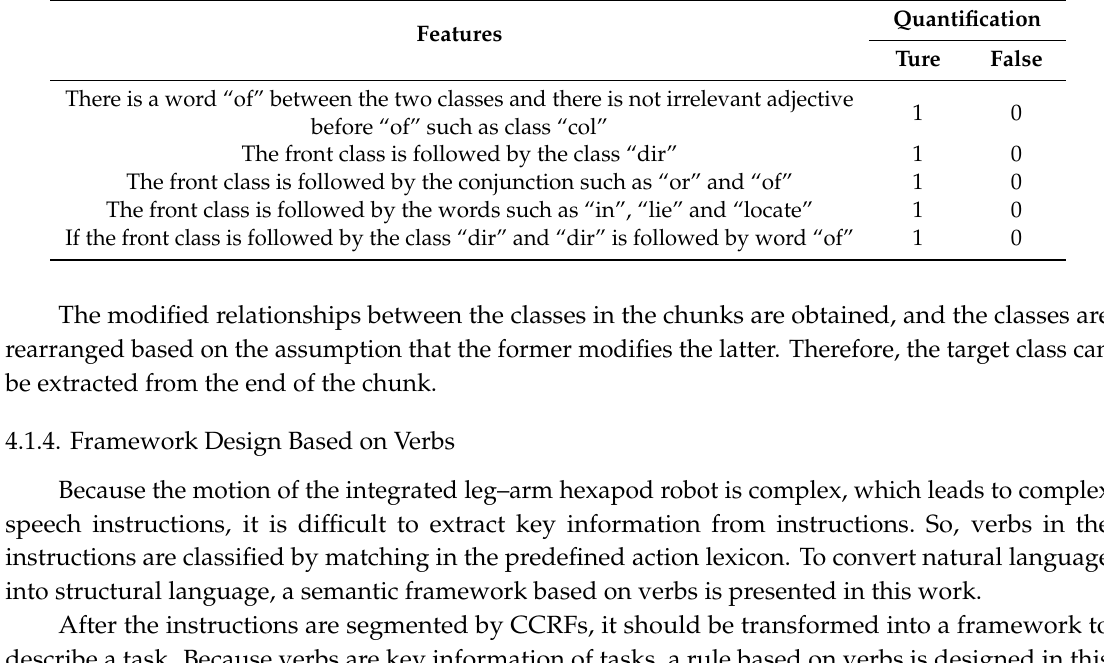
Table 7. Features that are put into the support vector machine